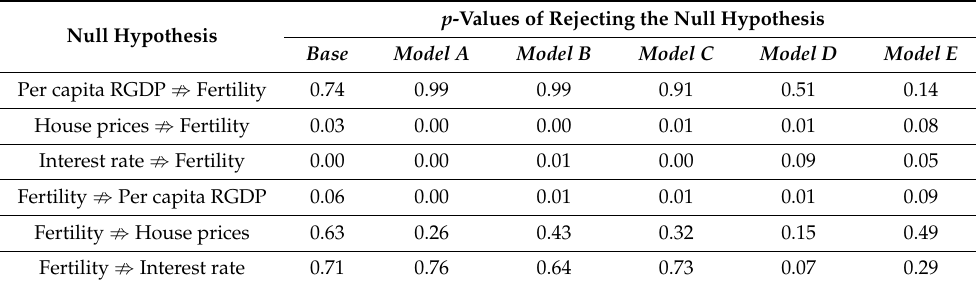
Table 4. Marginal significance levels ( p -values) of Toda–Yamamoto causality tests. p -Values of Rejecting the Null Hypothesis Null Hypothesis Base Model A Model